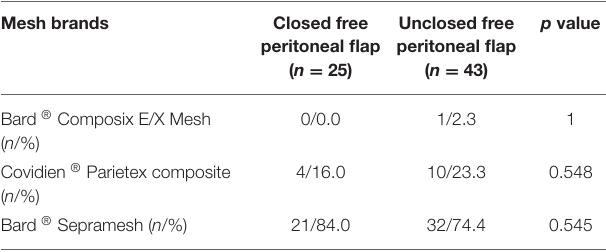
TABLE 2 | Mesh brands in two groups.